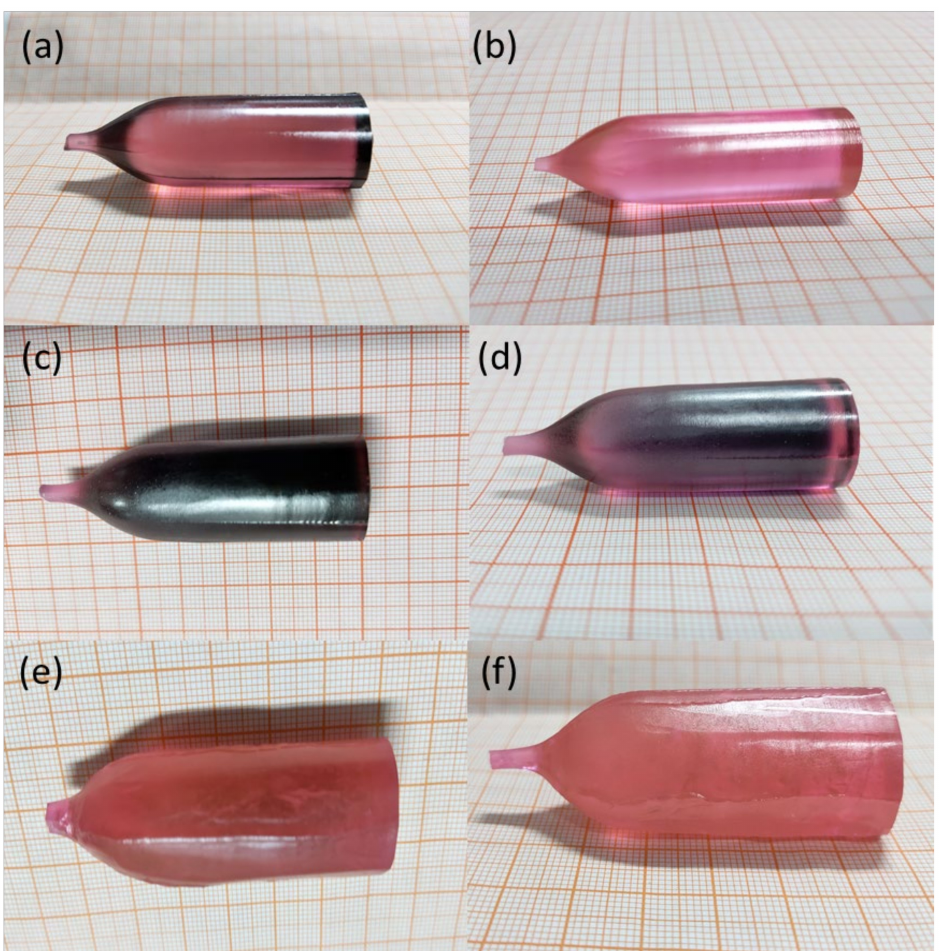
Figure 1. Images of crystal for ( a ) 10 at.% Er:CLNGG before annealing ( b ) 10 at.% Er:CLNGG after annealing ( c ) 15 at.% Er:CLNGG before annealing ( d ) 15 at.% Er:CLNGG after annealing ( e ) 30 at.% Er:CLNGG before annealing ( f ) 30 at.% Er:CLNGG after